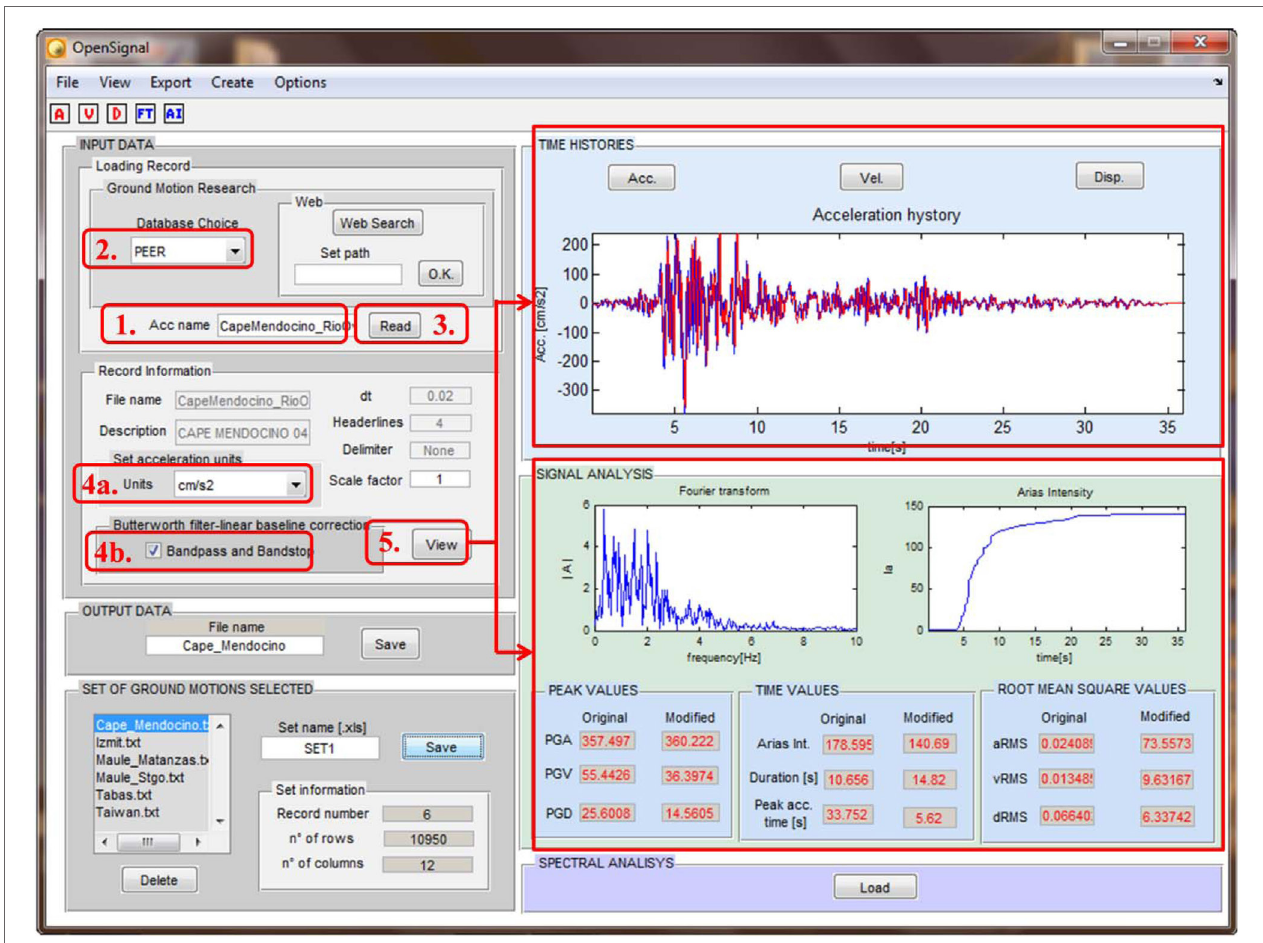
FigUre 2 | User dialog window for signal processing